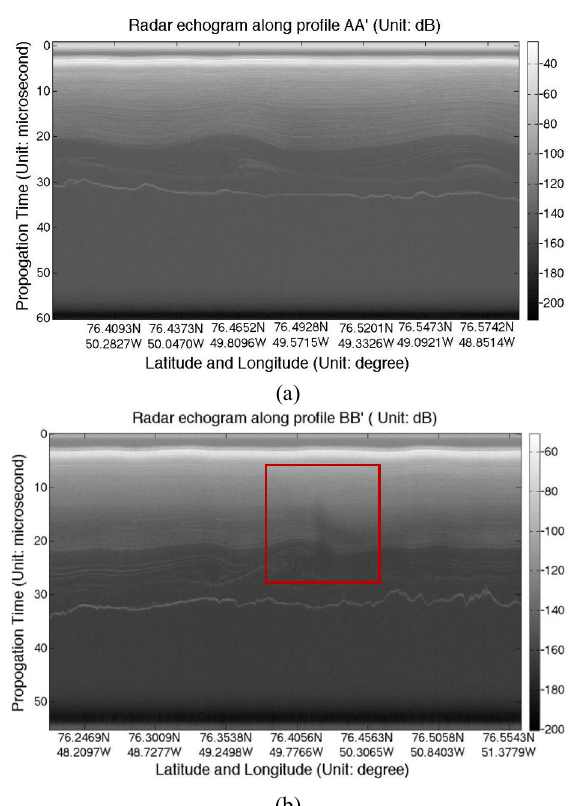
Figure 3. Radar echogram along profile (a) AA’ and (b) BB’. Obvious folding structures can be recognised from these